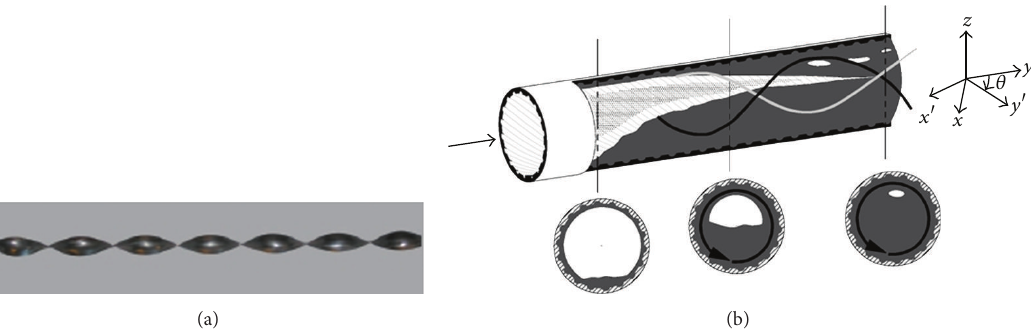
Figure 4: Suggested boiling enhancement geometries: (a) tape tube insert; (b) microfinned